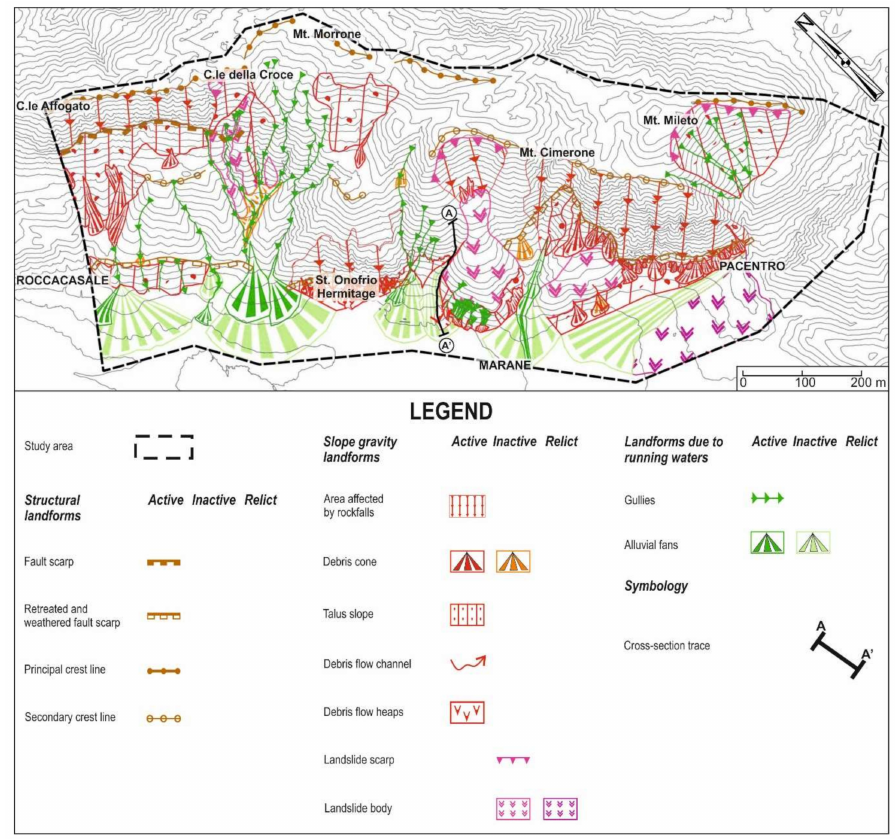
Figure 14. Geomorphological map of the study area. The cross-section trace matches with the August 2018 debris flow